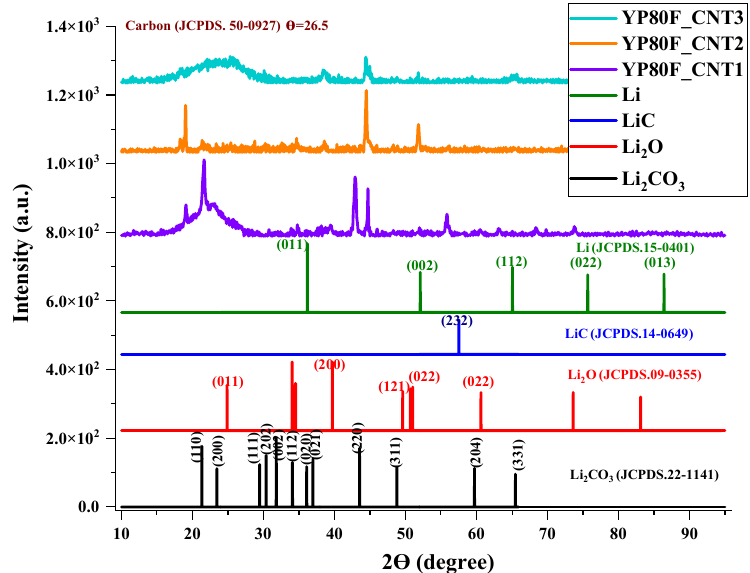
Figure 1. The results of the XRD analysis after examination after the electrochemical behavior of lithium.